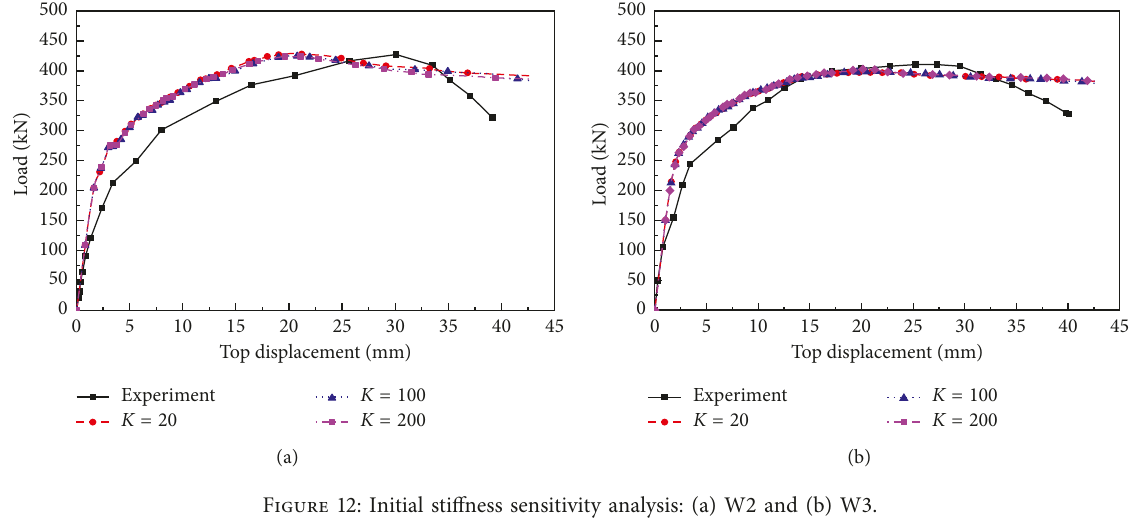
Figure 12: Initial stiffness sensitivity analysis: (a) W2 and (b) W3.